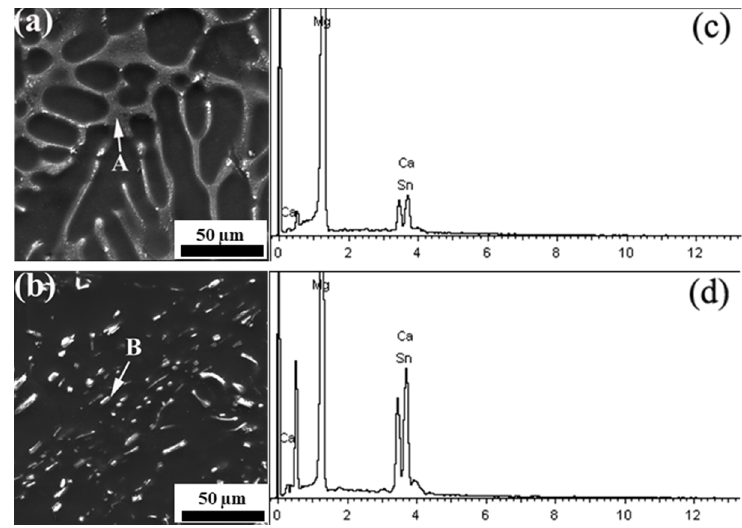
Figure 2. Microstructure of ( a ) as-cast and ( b ) extruded Mg–3CaMgSn master alloy samples; ( c ) EDS result of point A and ( d ) EDS result of point B.